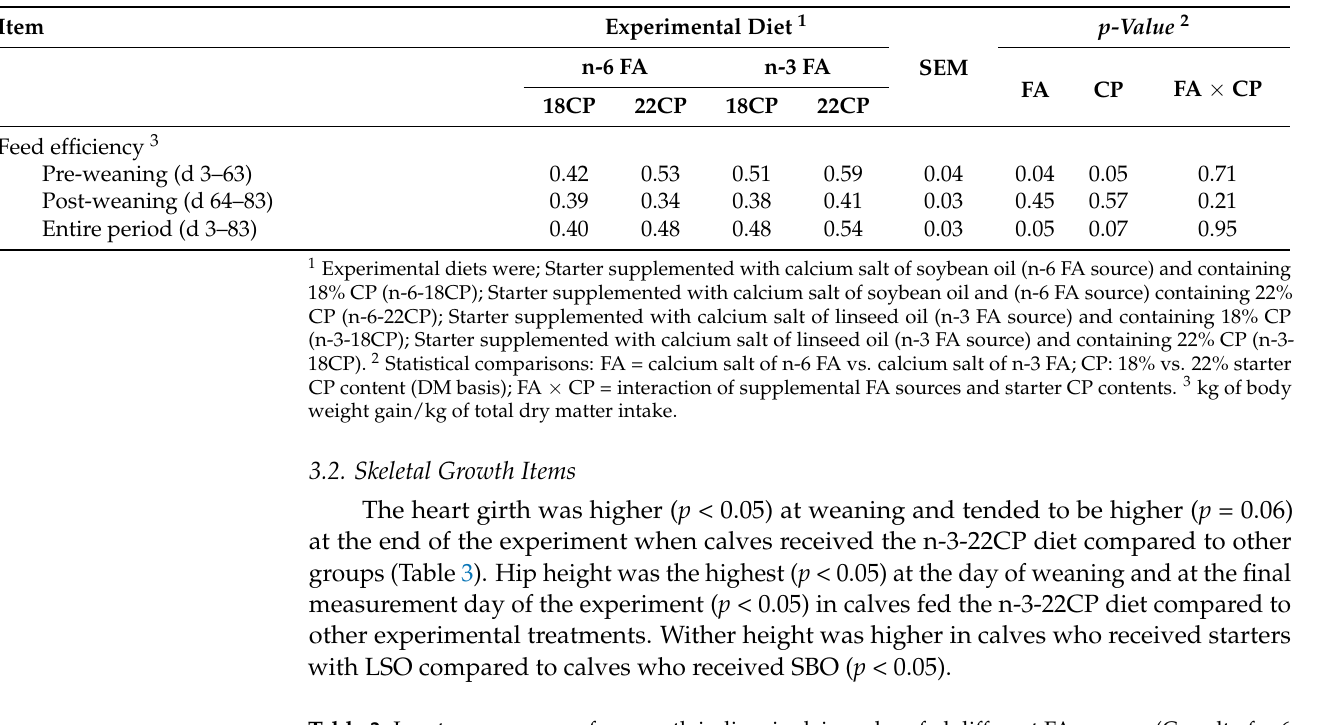
Table 3. Least square means for growth indices in dairy calves fed different FA sources (Ca-salt of